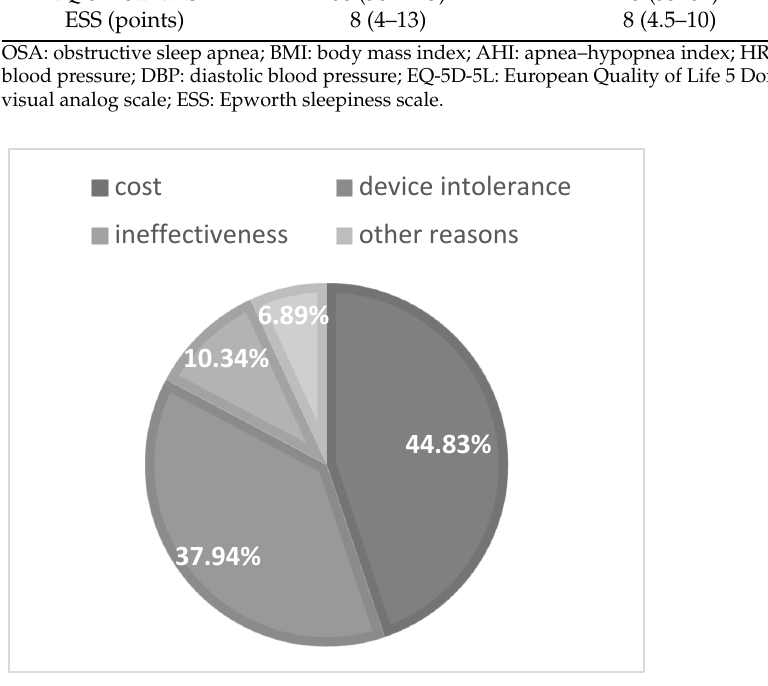
Figure 3. Reasons for PAP withdrawal. PAP: positive airway pressure. While the PAP-adherent patients presented a signi fi cant decrease in weight and BMI (Figures 4 and 5), the nonadherent patients exhibited a tendency toward weight gain that did not reach statistical signi fi cance ( p > 0.05) (Table 2). The HR increased in PAP-non- adherent patients (Table 2). While the DBP decreased in patients who continued to use PAP (Figure 6, Table 2), both the SBP and DBP increased in those who discontinued the positive airway treatment (Table 2). Although the median baseline ESS score was 8, corresponding to “normal” daytime somnolence, we observed a statistically signi fi cant improvement in daytime sleepiness both in the adherent and nonadherent patients (Table 2, Figure 7). According to the EQ-5D-5L questionnaire, most of the subjects reported no di ffi cul- ties with movement, self-care, daily activities and anxiety or depression. The EQ-5D-5L index signi fi cantly improved only in PAP-adherent patients (Table 2). The median VAS scale re fl ecting subjective quality of life also improved, with borderline statistical signi fi - cance, only in the PAP-adherent patients (Table 2). Table 2. Comparative analysis of clinical parameters, quality of life and daytime sleepiness, in PAP- adherent and -nonadherent groups. PAP-Nonadherent Baseline